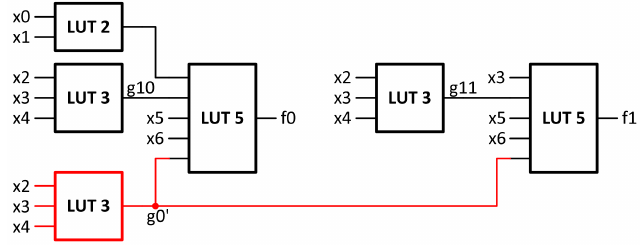
Figure 13. Technology mapping for functions f 0 and f 1